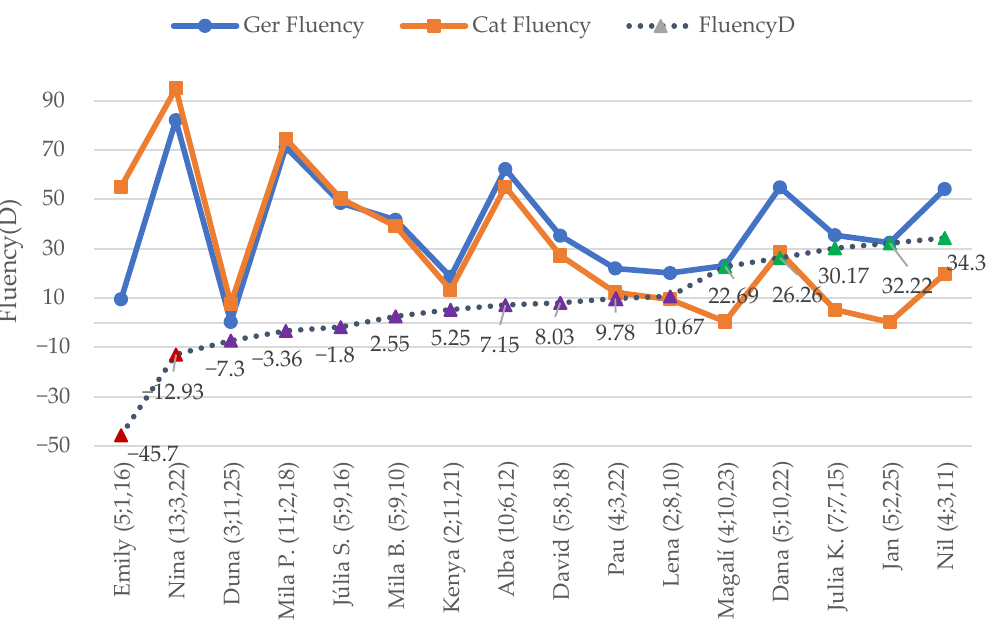
Figure 6. Children’s fluency in the MaL German and the HL Catalan.